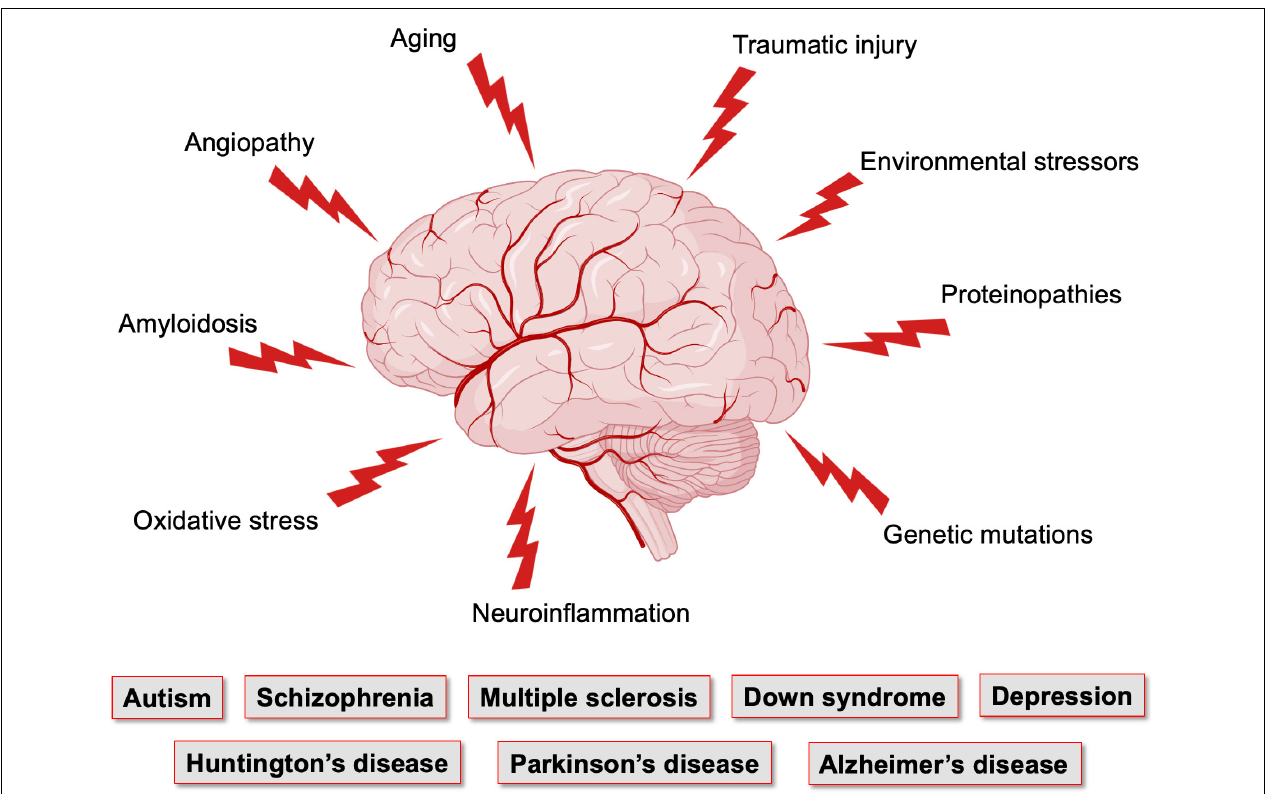
FIGURE 2 | Factors affecting the brain vasculature and leading to neurological conditions. The brain, which has elevated metabolic needs but poor energy storage, is highly dependent on a continuous supply of nutrients and oxygen from the blood stream, and is thus dependent on the integrity of its vasculature. Vasculature of the brain is the most complex and dense in the human body. Yet, it is maintaining a very fragile equilibrium and is the target of numerous pathological conditions that affect neuronal maturation and function. Figure made using BioRender